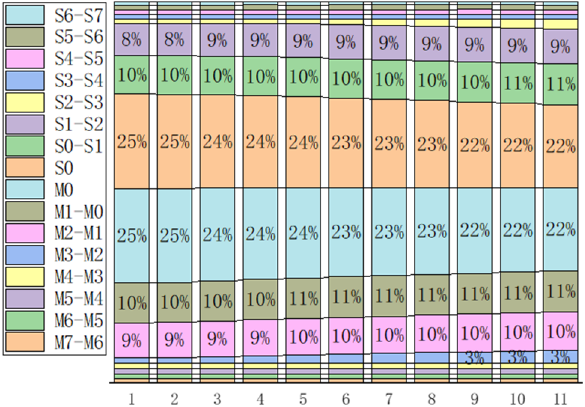
Figure 19. Energy distribution at each interface with the change in the slope of platform force.